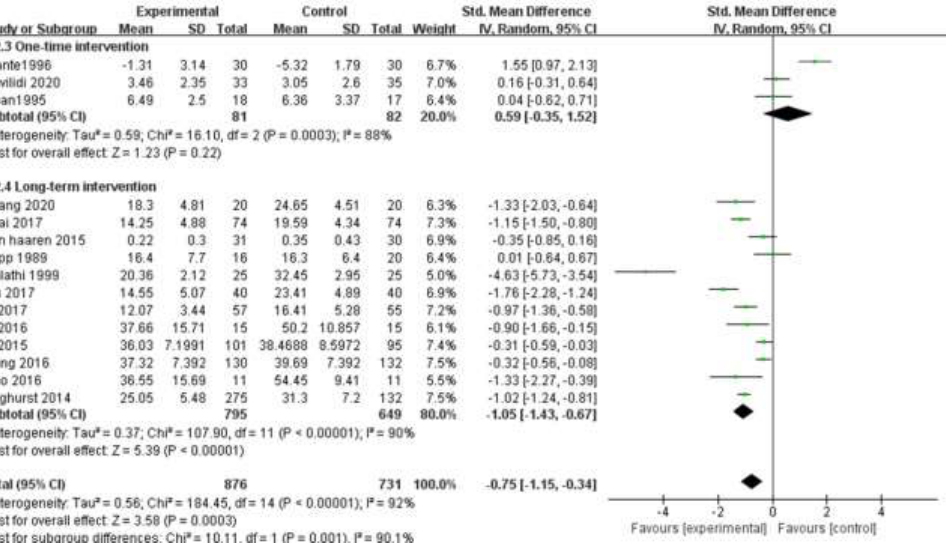
Figure 4. Subgroup analysis of intervention time [17–20,22–32]